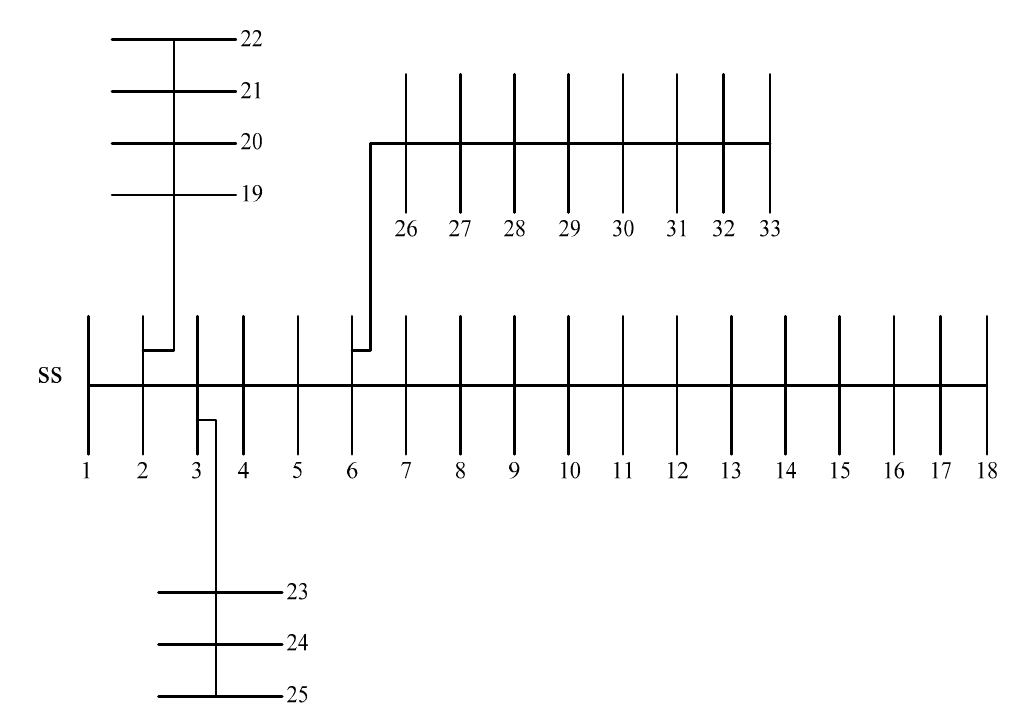
Table 2. Results of 33-bus system (Constant Load). Type